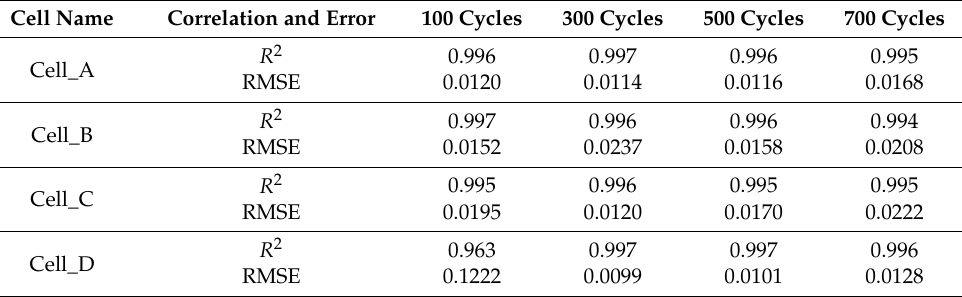
Table 1. Average R 2 and RMSE of the SOC estimations of all cells using cell A for model construction.